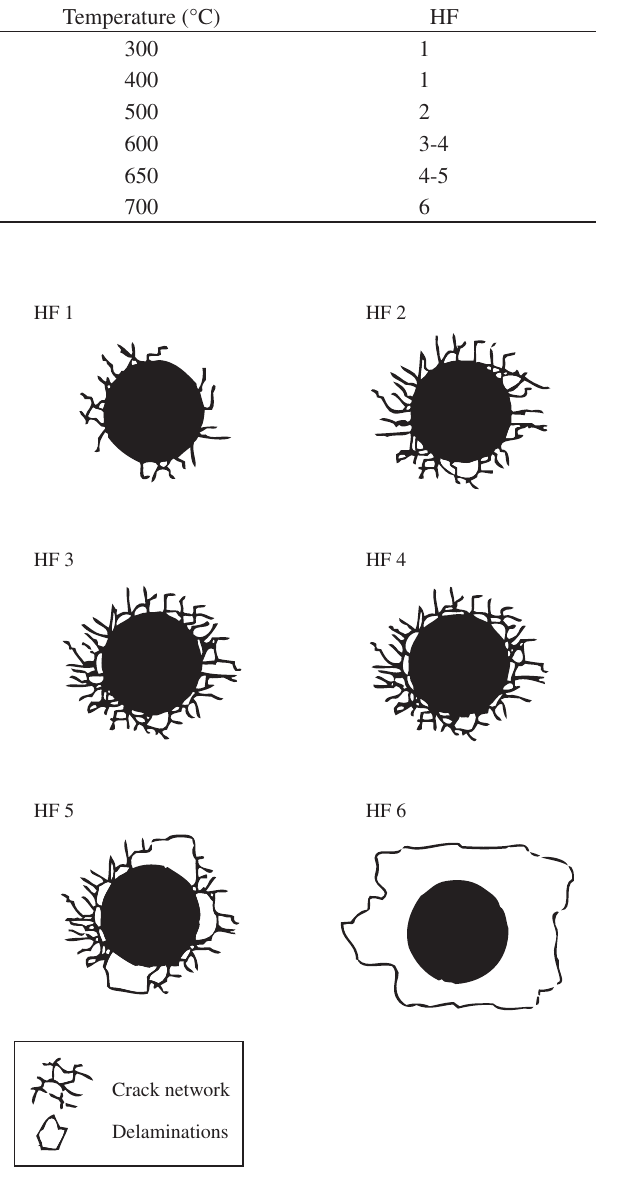
Figure 5. Adhesion strength quality HF 1 to HF 6 26 .